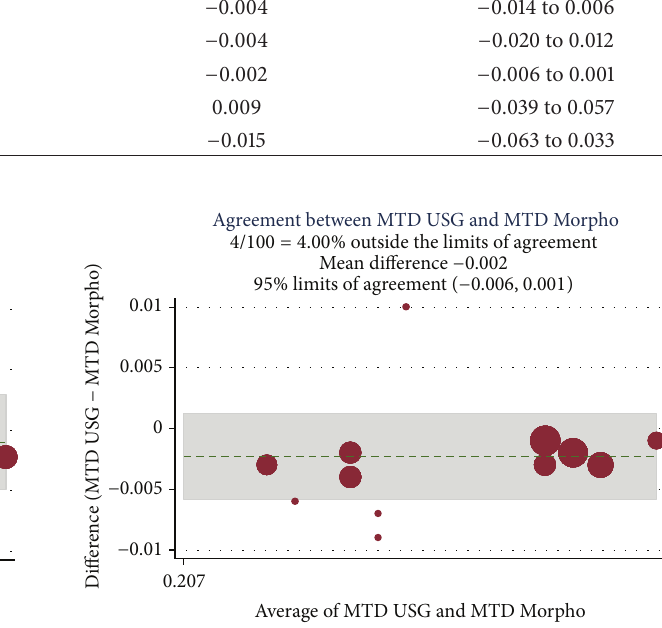
Figure 4: ICC was 0.89 with mean difference of − 0.002; limit of agreement was 95% with upper and lower limits of − 0.006 and 0.001. 4% values are above the limit of agreement, which means both of these methods are in